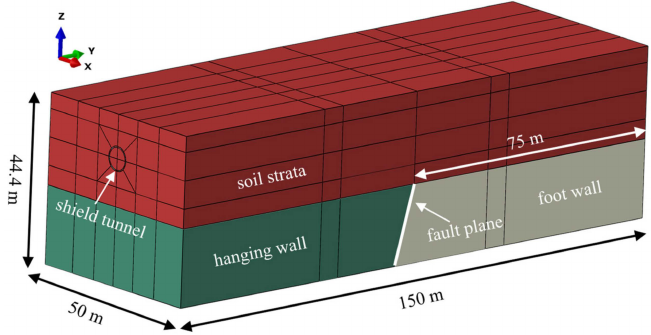
Figure 2. 3D numerical model of cross-fault segmental